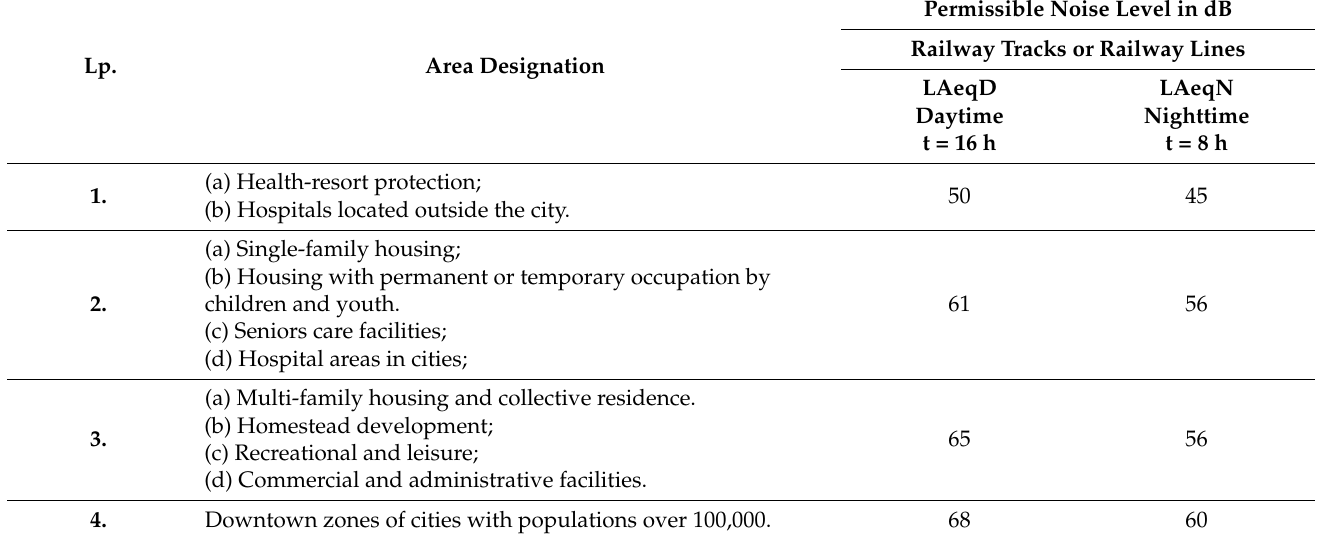
Table 3. Classification of protected areas and acceptable values for environmental noise levels expressed as LAeqD and LAeqN indicators for railway